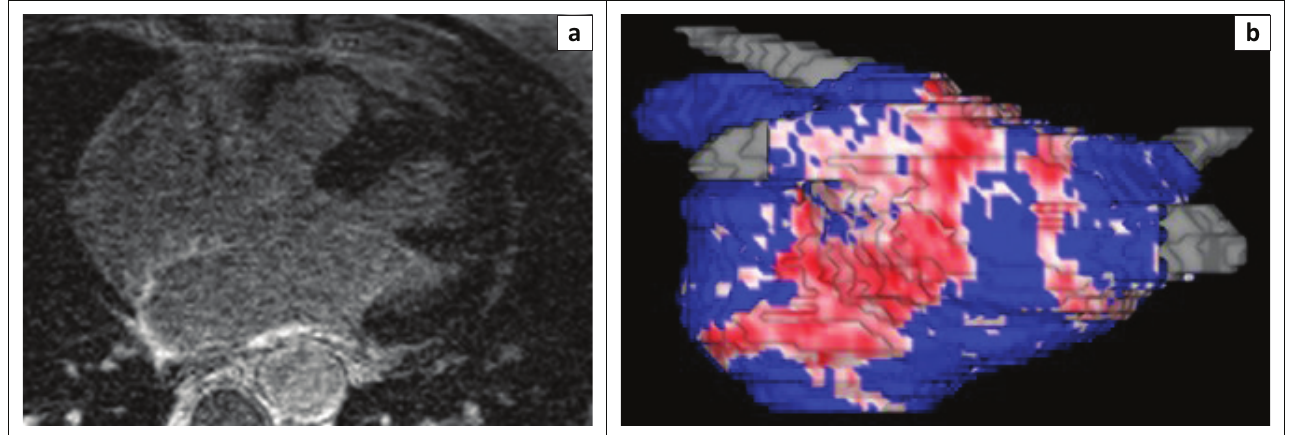
FIGURE 8: Late gadolinium enhancement (a) of the left atrium post ablation. Ablation lesions present as bright signal on an otherwise dark myocardium; (b) 3D map representation of the scar (red) distribution.